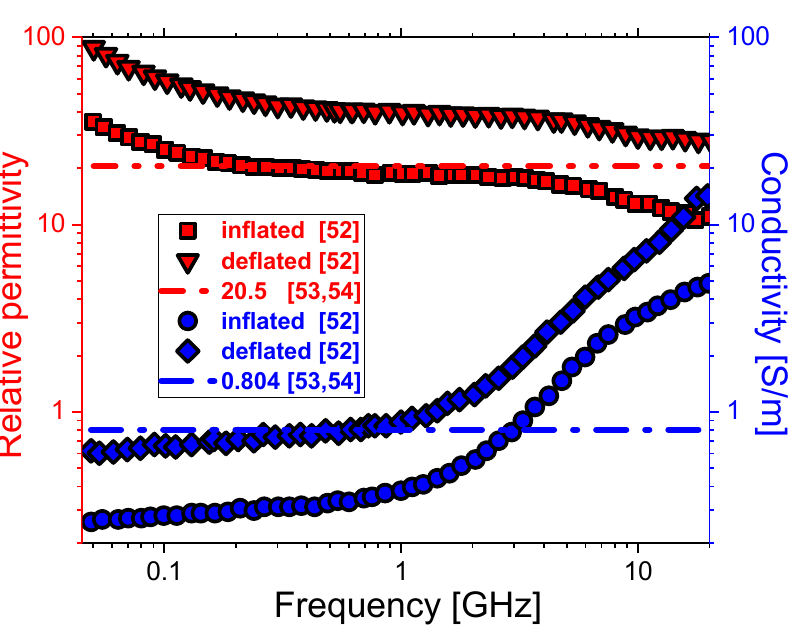
Figure 2. The frequency dependence of the relative permittivity (squares and down triangles) and conductivity (circles and diamonds) of the inflated and deflated lungs, respectively [52]. Curves correspond to the constant values of dielectric properties of the lungs regardless of respiration [53,54].